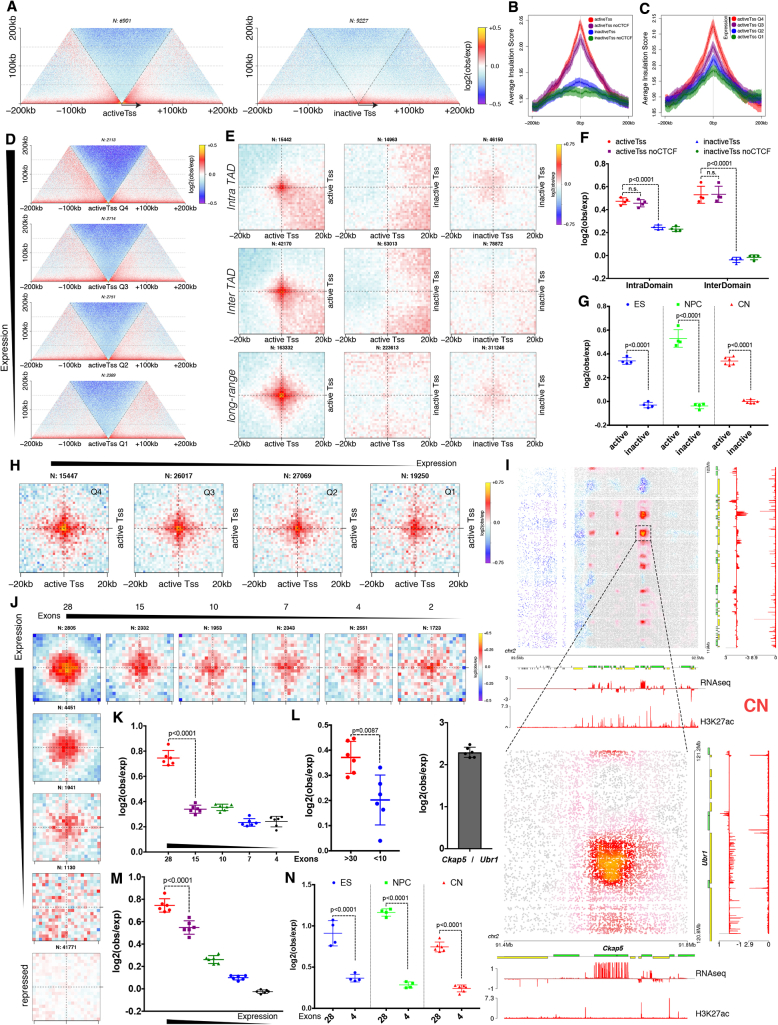
Long-Range Interactions between Active Promoters and Gene Bodies with Many Exons(A) Aggregate Hi-C maps in NPCs centered on either active or repressed gene promoters with no CTCF binding site within ± 5 kb.(B) Average insulation score centered on gene promoters in NPCs. Lines show mean values; dark and light shaded ribbons represent SD and 95% confidence interval, respectively.(C and D) Average insulation score (C) and aggregate Hi-C maps (D) centered on active gene promoters in NPCs separated into quartiles based on expression.(E) Aggregate Hi-C contact maps around pairs of gene promoters in NPCs with no CTCF binding site within ± 5 kb.(F and G) Quantification of the contact strength between pairs of either active or repressed Tss (F) or between inter-TAD pairs of either active or repressed Tss (G). Data are represented as a scatter dot plot showing the mean ± SD. Statistical significance is calculated using two-way ANOVA with Tukey’s test.(H) Aggregate Hi-C contact maps around pairs of active gene promoters in NPCs separated into quartiles based on expression. Shown are long-range (2- to 10-Mb) inter-TAD interactions.(I) Example of clusters of long-range loops between gene bodies in CNs. Also shown is a zoomed-in interaction between the Ckap5 and Ubr1 genes and quantification of the contact enrichment. Genes transcribed in the forward direction are represented by green rectangles and genes in the reverse orientation are represented by yellow.(J) Aggregate Hi-C maps between long-range (10- to 50-Mb) pairs of genes (central bin represents the middle of the gene) separated in quantiles based on either number of exons (shown is the average number of exons in a quantile) or gene expression. Shown are 160 × 160 kb windows with a bin size of 8 kb.(K–N) Quantification of the contact enrichment between genes (25-kb bins around the center of the gene) by the average number of exons (K), by the number of exons in genes with comparable length (L), by average expression (M), and in different cell types (N). Data are represented as a scatter dot plot showing the mean ± SD. Statistical significance is calculated using two-way ANOVA with Tukey’s test.In all panels, n refers to the number of intervals or pairs examined. See also Figure S5.